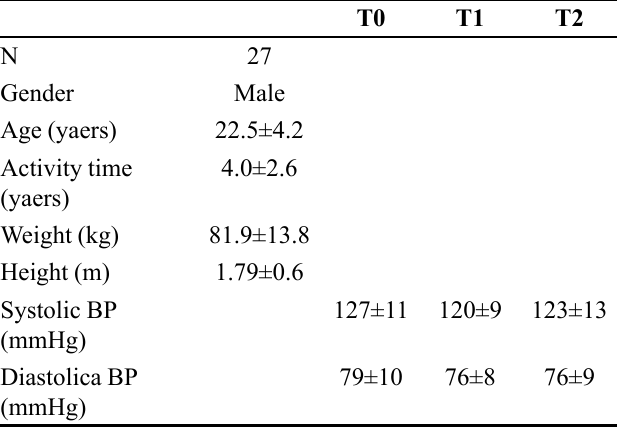
TABLE II - Basic characteristics of the study population